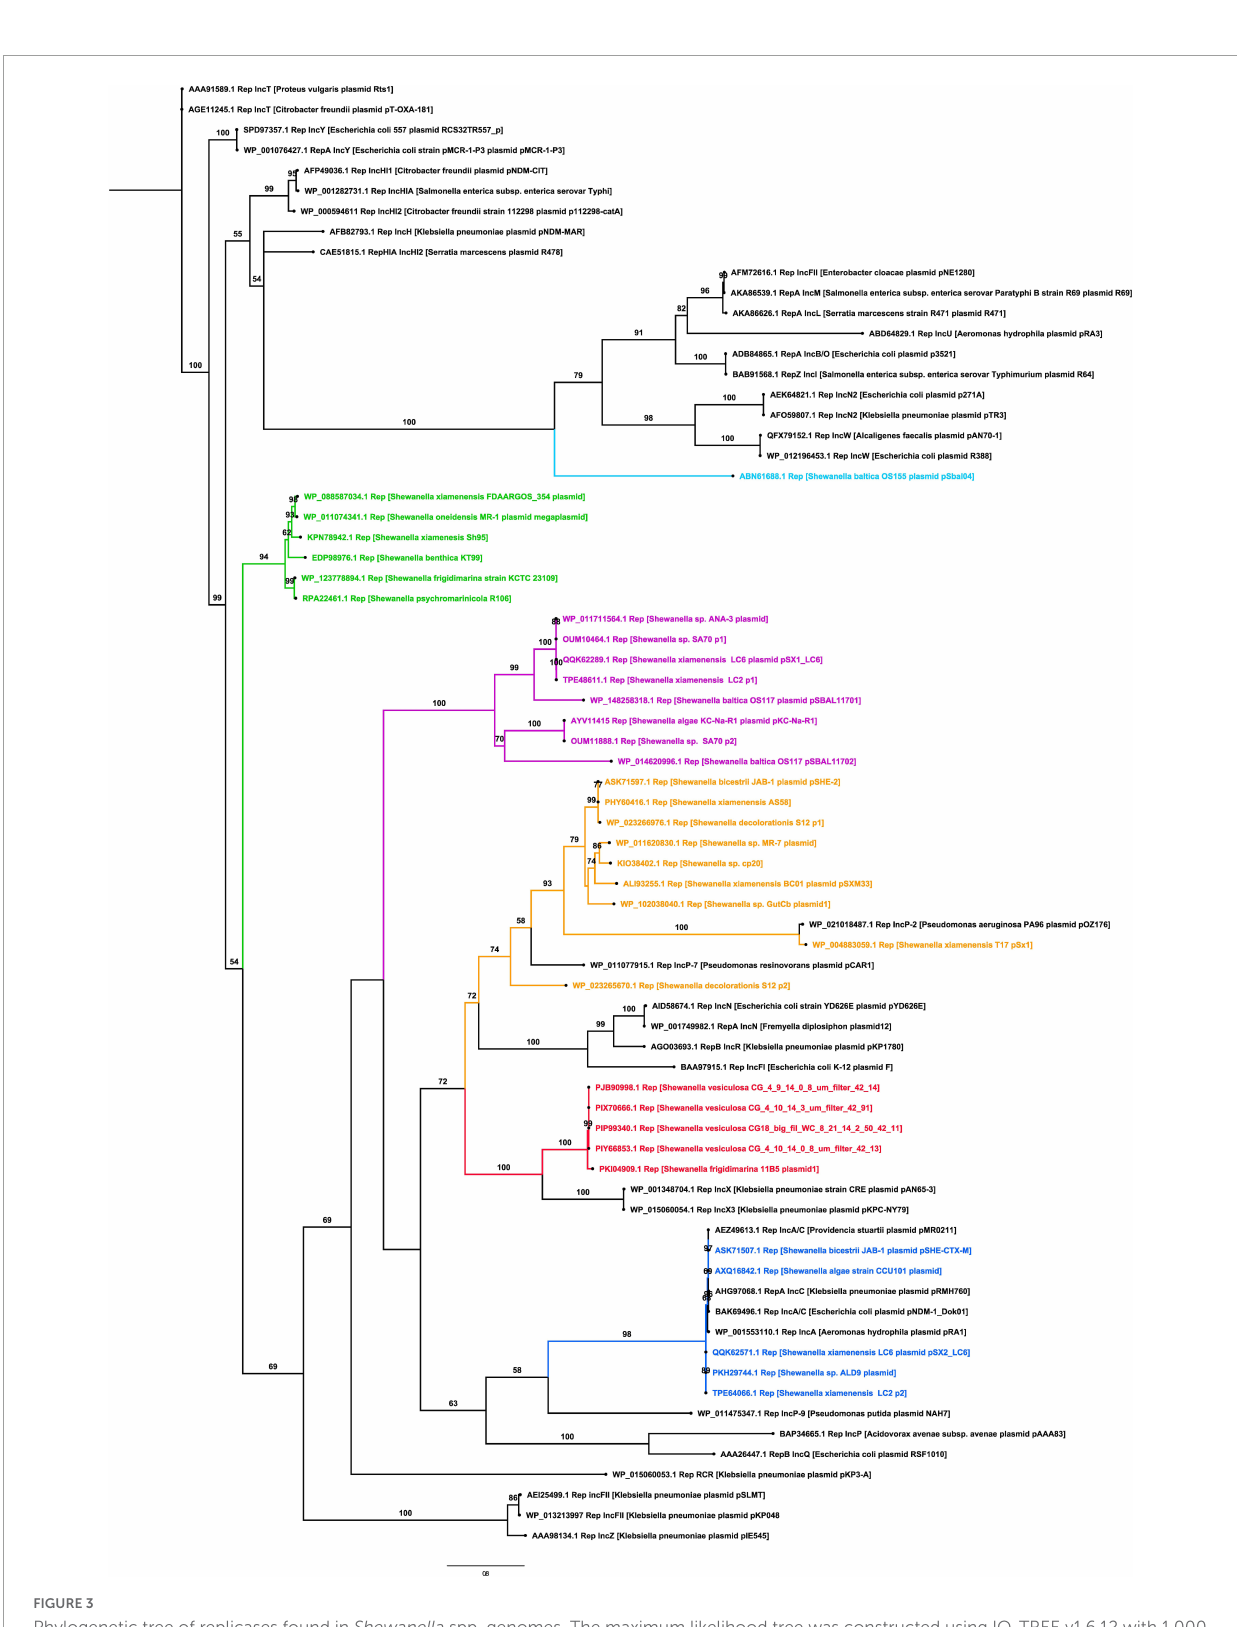
FIGURE3 Phylogenetic tree of replicases found in Shewanella spp. genomes. The maximum likelihood tree was constructed using IQ-TREE v1.6.12 with 1,000 bootstraps. Numbers above branches indicate bootstrap support (%). Branches in red contain plasmids related to IncX incompatibility group, branches in blue contain plasmids related to the IncA/C group, branches in yellow contain plasmids related to IncP group, branches in green and purple comprise independent clusters of unknown replicases, and black branches depict known